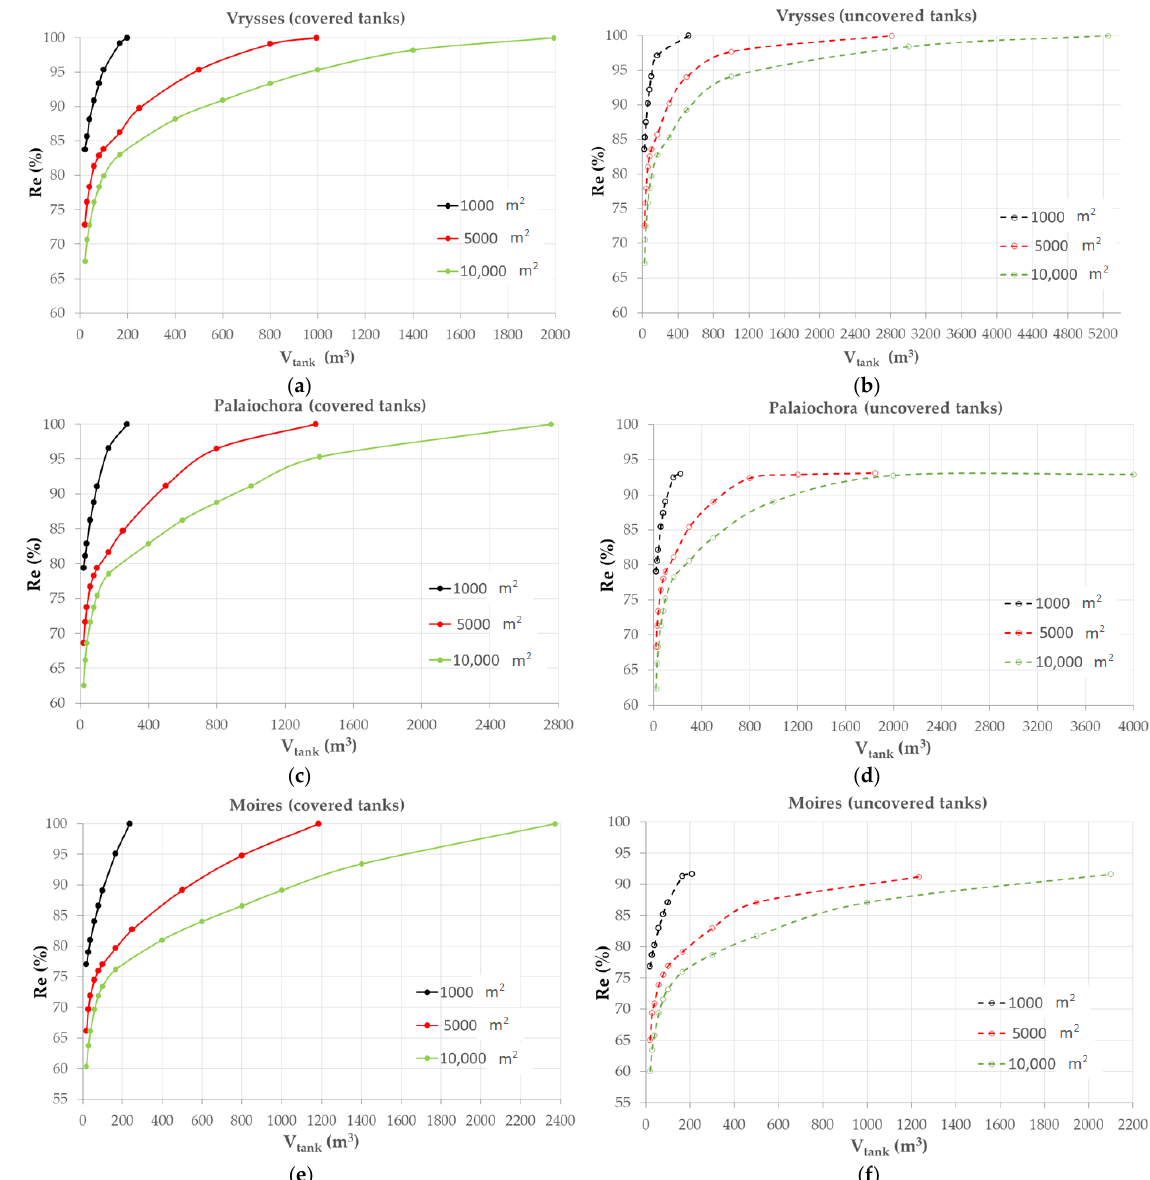
Figure 6. Reliability curves of rainwater harvesting systems with covered and uncovered tanks for meeting the tomato crop water needs for greenhouse runoff covering 1000, 5000 and 10,000 m 2 in the ( a , b ) Vrysses, ( c , d ) Palaiochora and ( e , f ) Moires study areas.